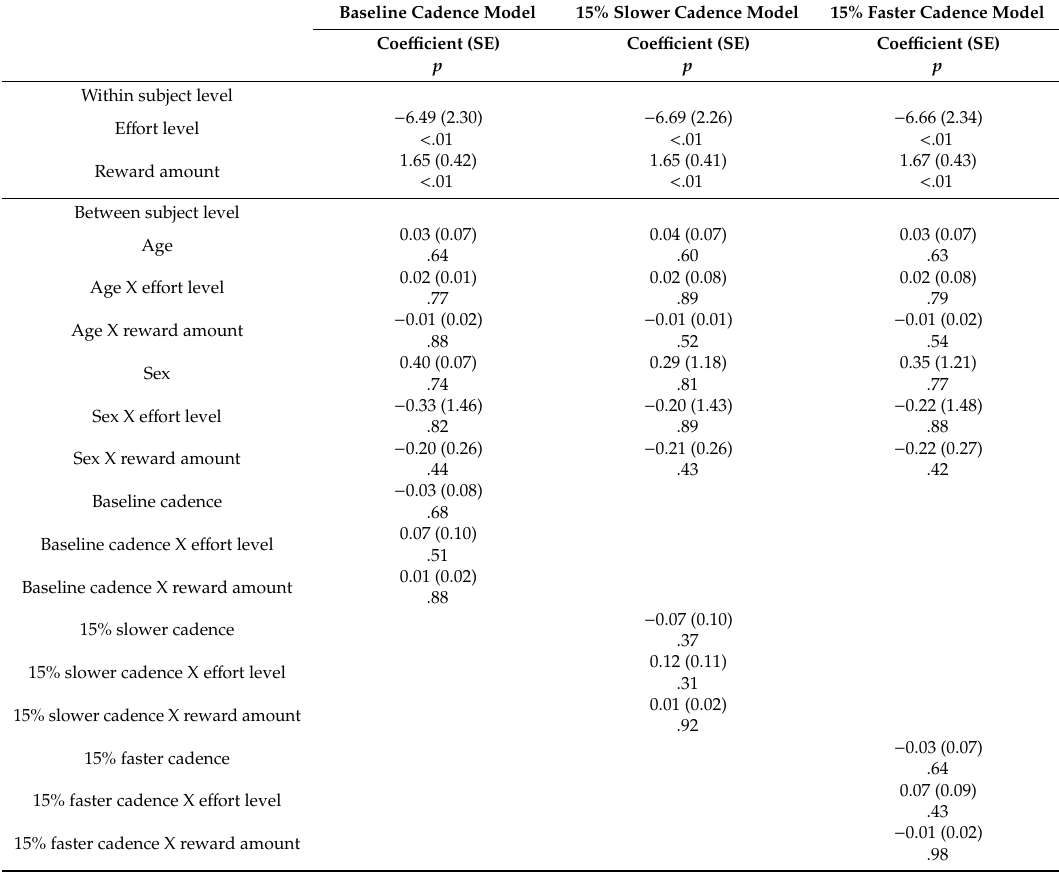
Table 3. Within subject-level and between subject-level predictors of e ff ortful choices ( N =